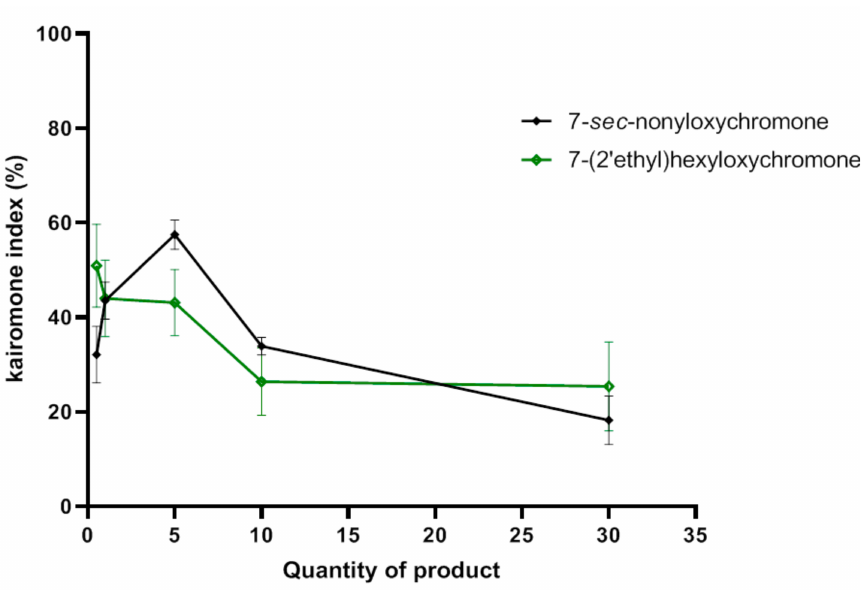
Figure 7. Attractant effects (SD) of 7- sec -nonyloxychromone ( 12 ) and 7-(2 (cid:48) ethyl)hexyloxychromone ( 13 ) towards Aedes albopictus